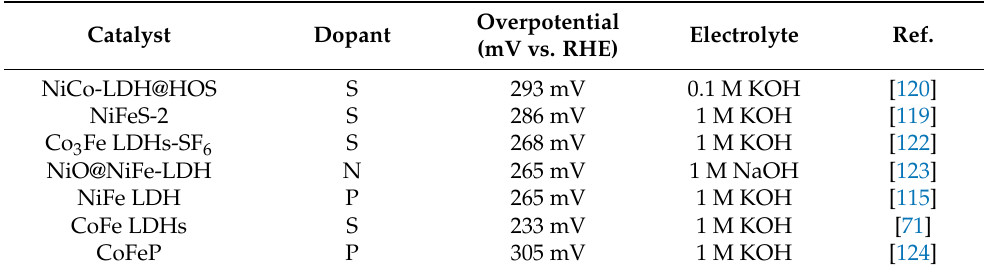
Table 2. Comparison of OER activities of anion-doped TM-LDHs under alkaline conditions at current density of 10 mA cm − 2 . Catalyst Dopant